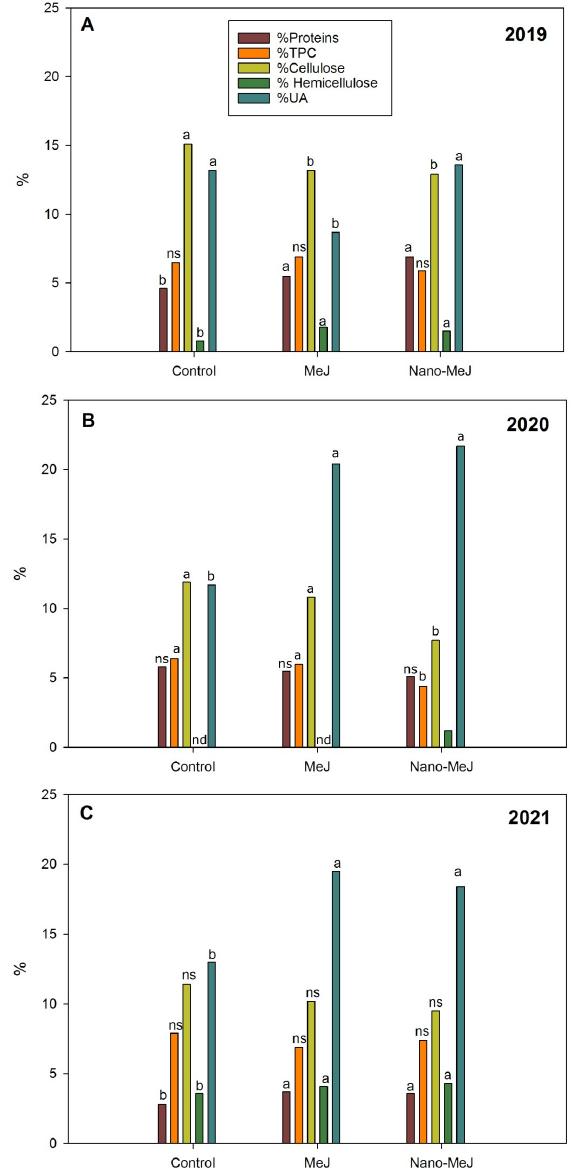
Figure 1. Skin cell wall composition in Monastrell grapes untreated and treated with MeJ and nano- MeJ during three years (( A ) 2019, ( B ) 2020 and ( C ) 2021). Different letters with the same bar colour indicate significant differences according to LDS test. (ns; not significant).